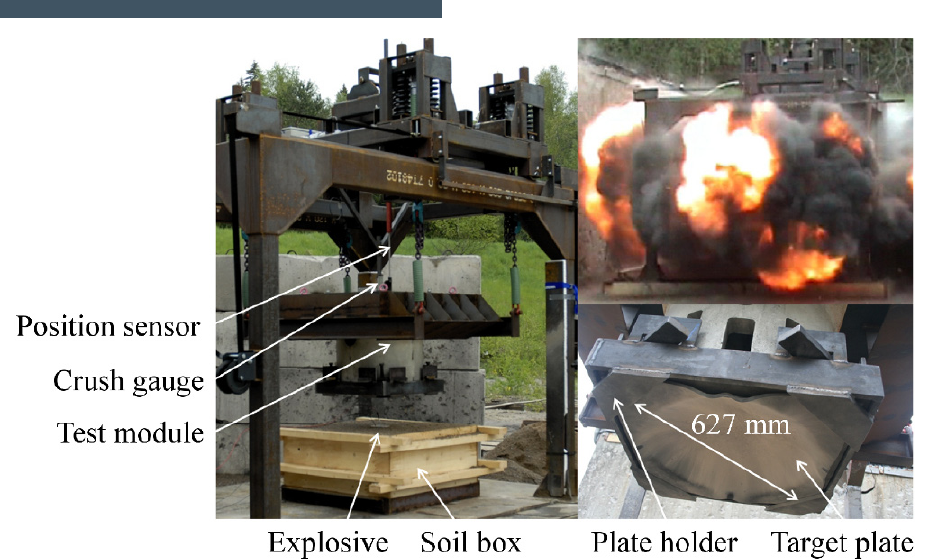
Figure 1. Blast trial. At left, complete experimental setup. At upper right, explosive gas cloud, at lower right, test module with deformed target plate and plate